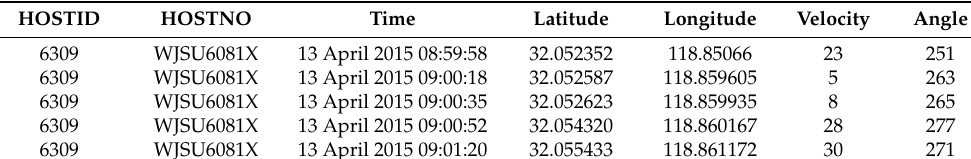
Table 1. The records of GPS information on fire-engine trajectory.